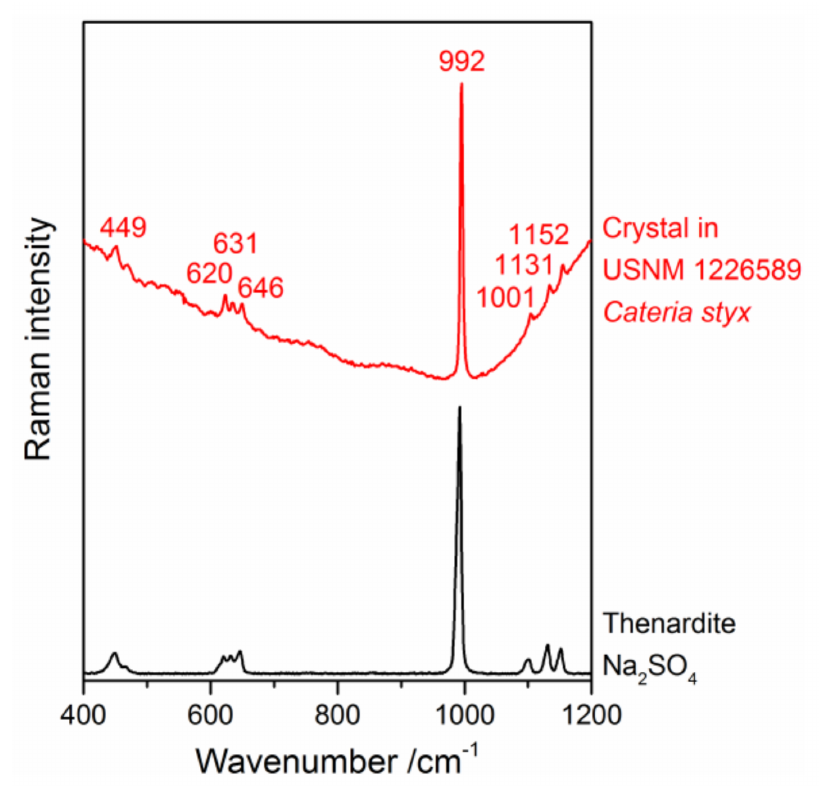
Figure 17. Raman spectrum of a crystal found in sample USNM 1226589, Cateria styx , in an unknown mounting medium (red) in comparison with the reference spectrum of the mineral thenardite (Na 2 SO 4 , black) from the RRUFF spectral database library